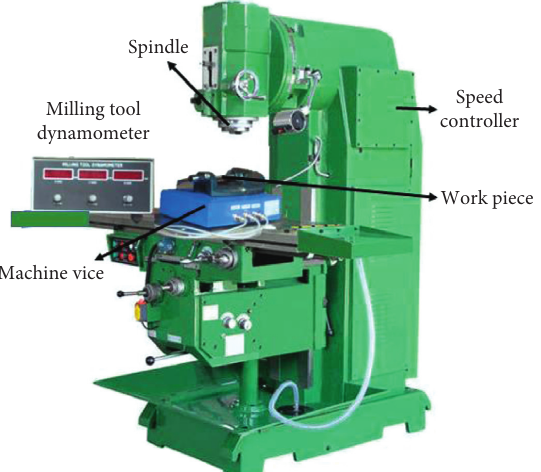
Figure 2: Vertical machining center used for experimentation in this research work.